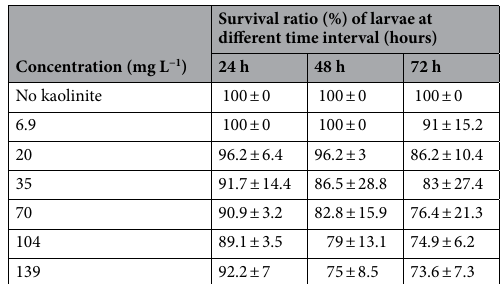
Table 1. Survival ratios (%) of nauplius larvae exposed to different suspended particle concentrations. All values are expressed as mean ± SD ( n =